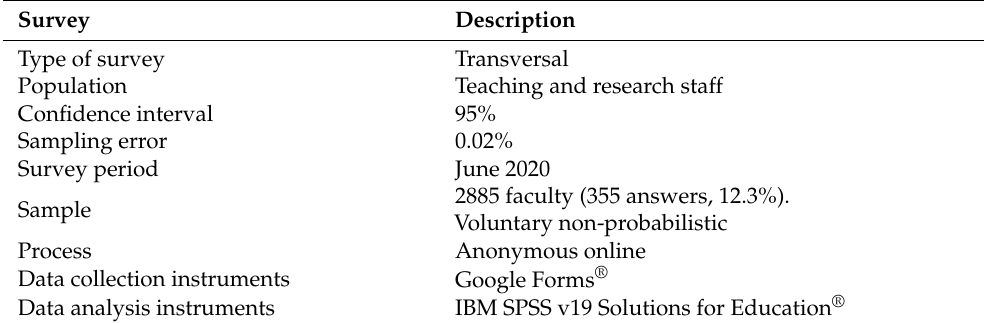
Table 2. Most important design aspects of the survey.